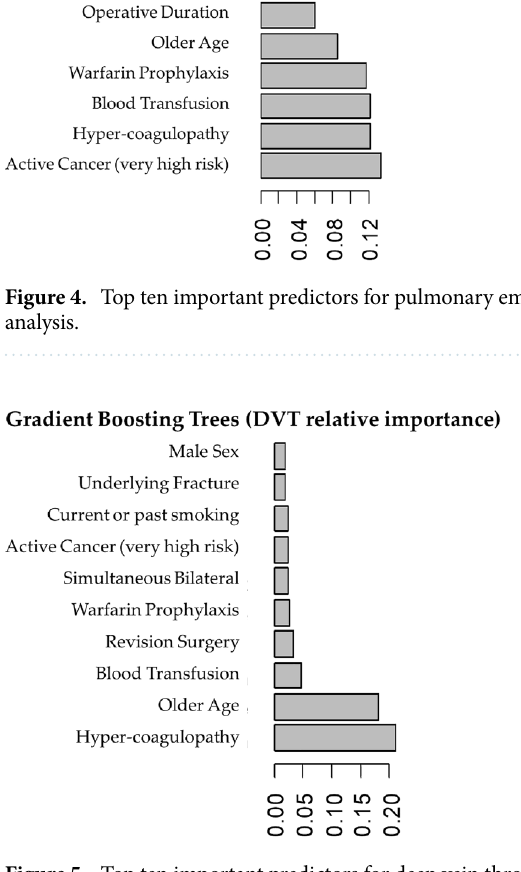
Figure 5. Top ten important predictors for deep vein thrombosis (DVT) as captured by gradient boosting tree analysis.